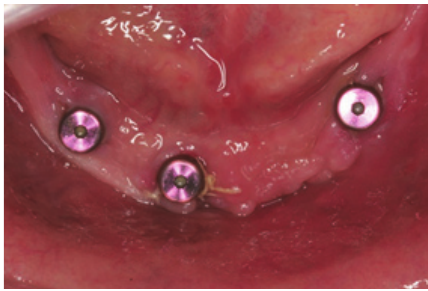
Figure 4: Three 5 mm healing abutments placed on the remaining implants.